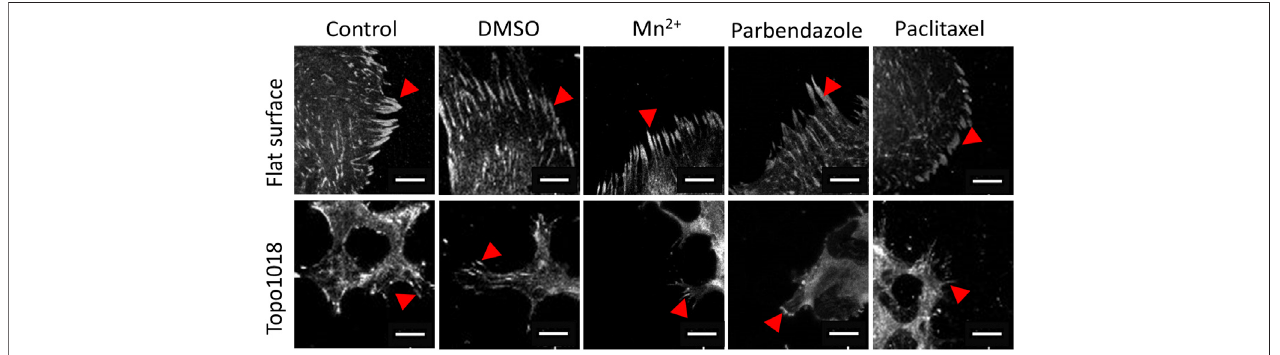
FIGURE 8 | Small molecule-targeting microtubule stabilization resulted in shorter focal adhesions. We cultured hMSCs on the fl at and Topo1018 surfaces and treatedthemwithsmallmoleculestargeting integrins(Mn 2+ ),F-actin,and microtubules(paclitaxelandparbendazole),andwestainedthemwithvinculintovisualizefocal adhesions and pointed them with red arrows. Scale bars represent 10 µM. For all experiments, N = 3.